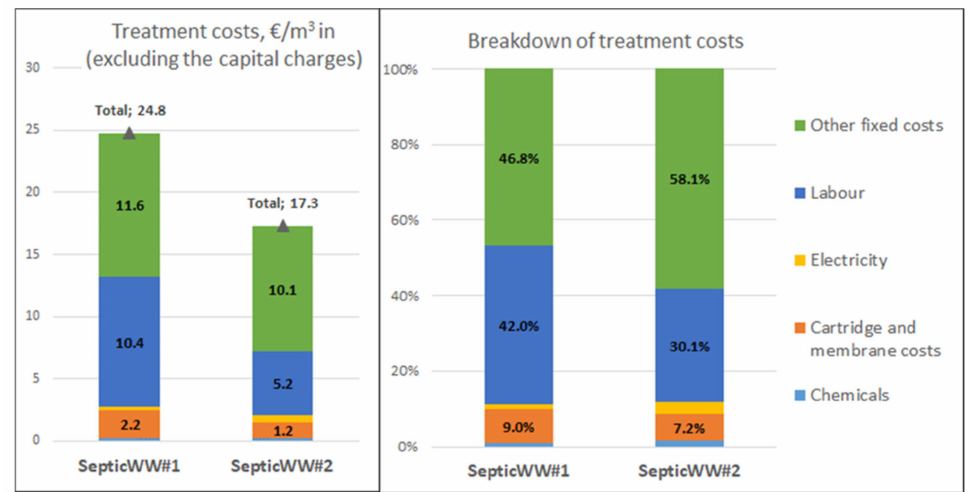
Figure 13. The total treatment cost estimates (EUR/m 3 in) excluding the capital charges and the breakdown of the costs for the SepticWW concepts.